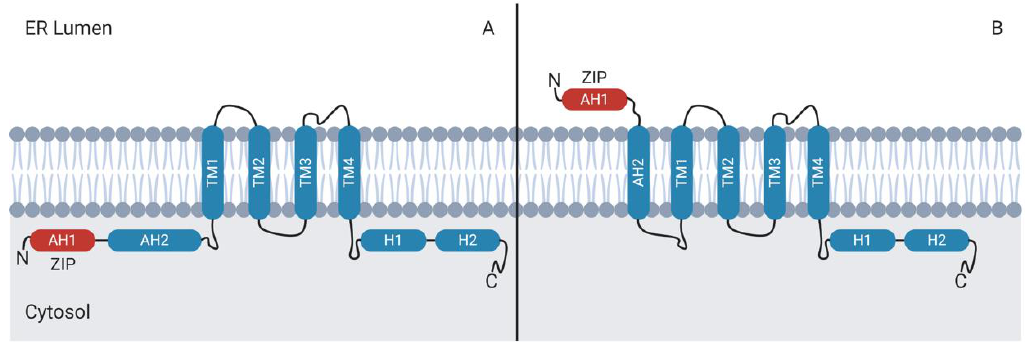
Figure 5. Topology of NS4B in the ER membrane. ( A ) The AH2 amphipathic helix domain can be positioned on the cytosolic face of the ER, along with the amino-terminal AH1 domain. ( B ) Insertion of AH2 in the ER membrane translocates the AH1 domain to the ER lumen. It is not yet known how altered NS4B topology affects protein function. TM: transmembrane, AH: amphipathic helix.